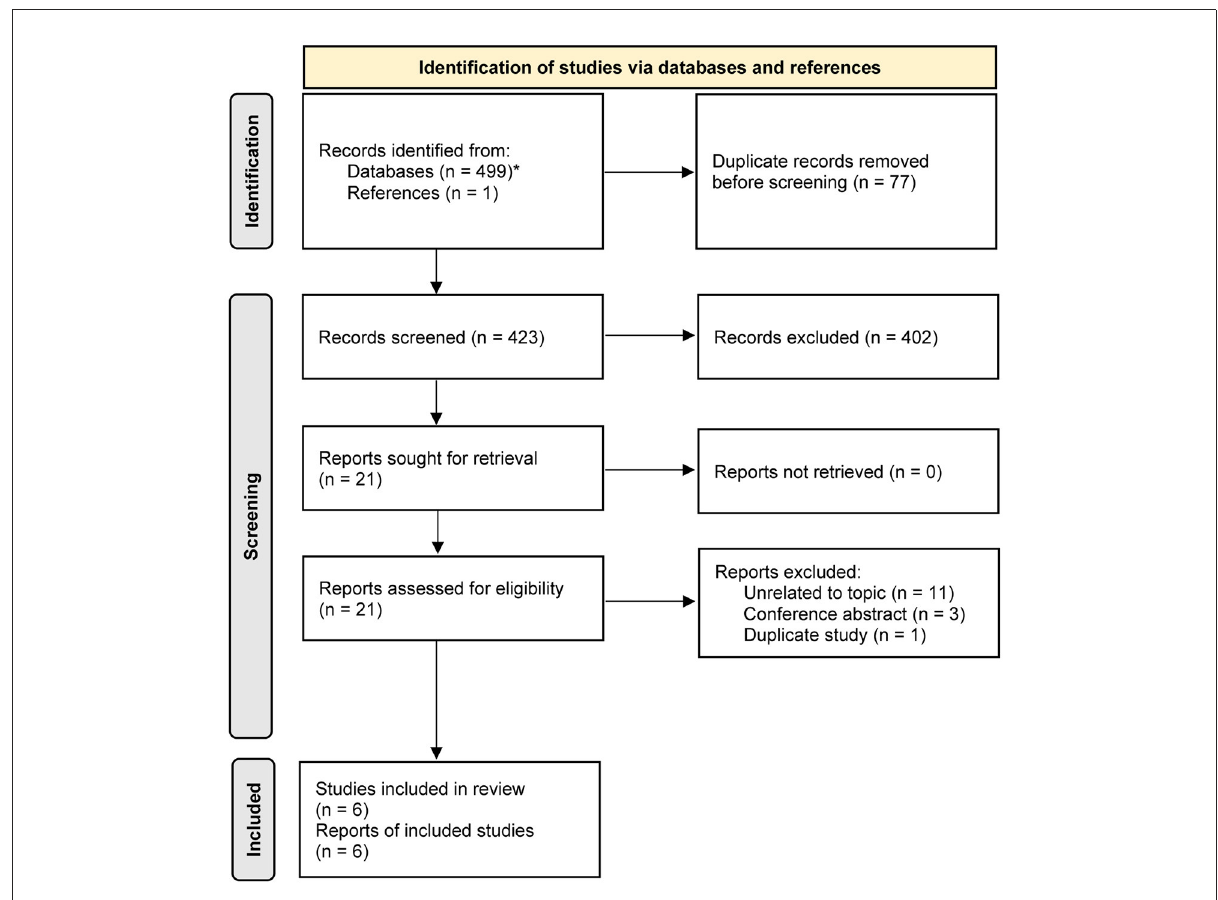
FIGURE1 PRISMA flow chart of selecting